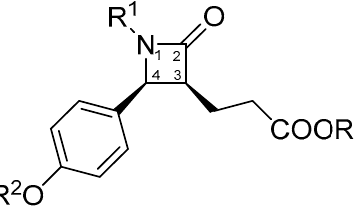
Figure 1. The structural elements necessary for the activity.